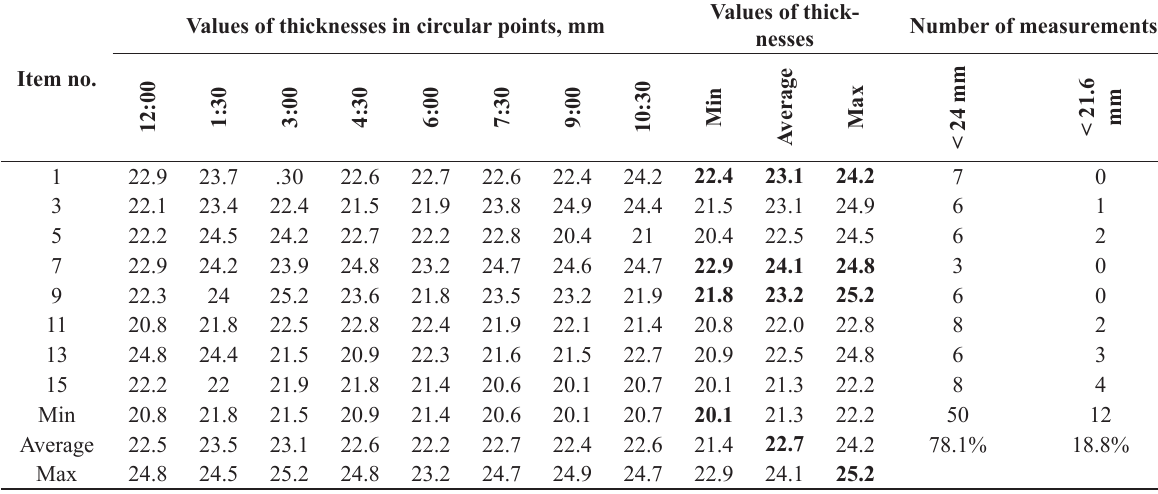
Values of thick- Number of measurements nesses